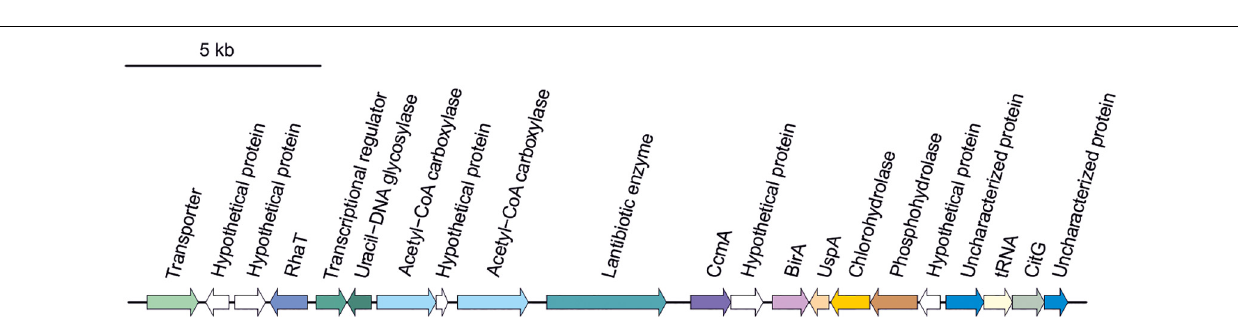
FIGURE 6 | Lanthipeptide biosynthetic gene cluster identified in Halomicroarcula salina JCM 18369 T